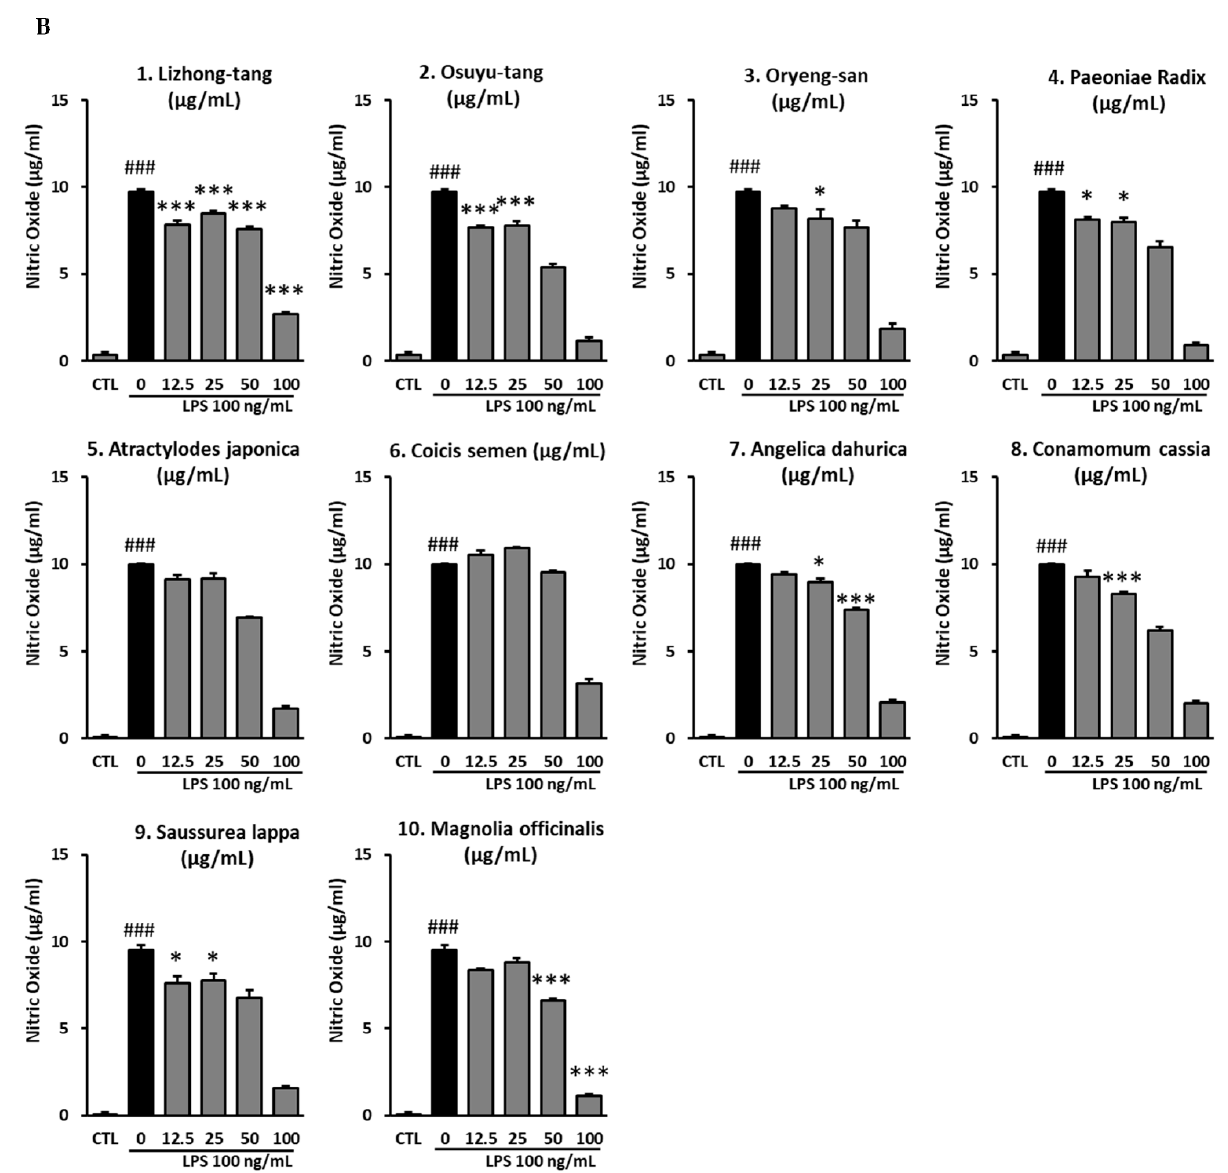
Figure 2. Effects of the 10 extracts on inhibition of nitric oxide (NO) production. RAW 264.7 cells were pre-treated with various concentrations of the 10 extracts. ( A ): Cytotoxic effects of the 10 extracts. ( B ): NO production upon treatment with the 10 extracts. Results have been expressed as mean ± SEM ( n = 3). Statistical analysis was carried out by means of ANOVA with Tukey’s post-hoc test, using software R version 3.3.3. # p < 0.05, ## p < 0.01, ### p < 0.001, compared to the non-treated group; * p < 0.05, *** p < 0.001, compared to the LPS-treated group.